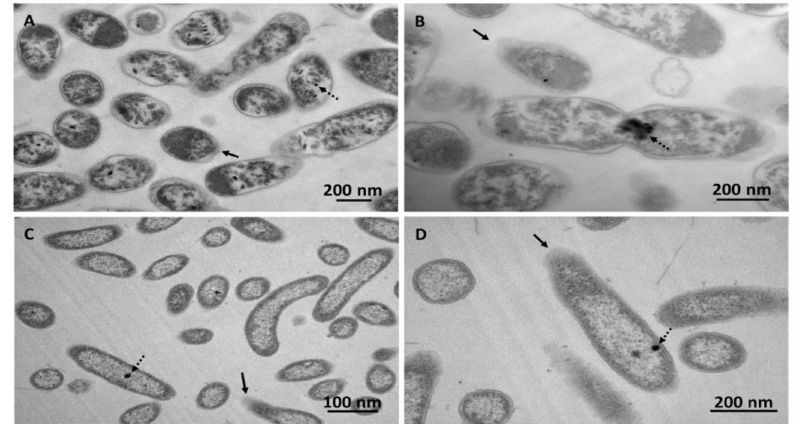
Figure 4. Transmission electron micrographs of PS27 ( A , B ) or PDMF10 ( C , D ) grown for 72 h in the co-presence of PFHxS and the mixture ethanol-octane or octane, respectively. Black arrows and dashed ones indicate cell structural features and electron-dense accumulation, respectively.